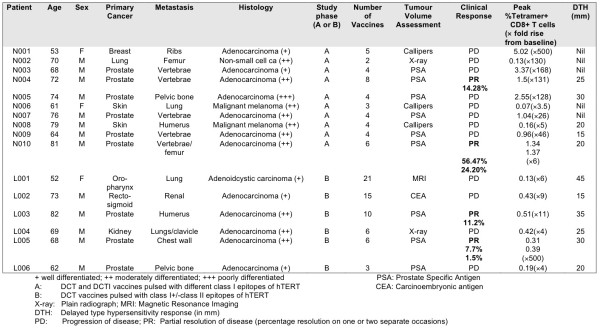
Clinico-pathological summary. Relevant clinical and pathological data for all patients who underwent vaccination with hTERT-pulsed DCs.